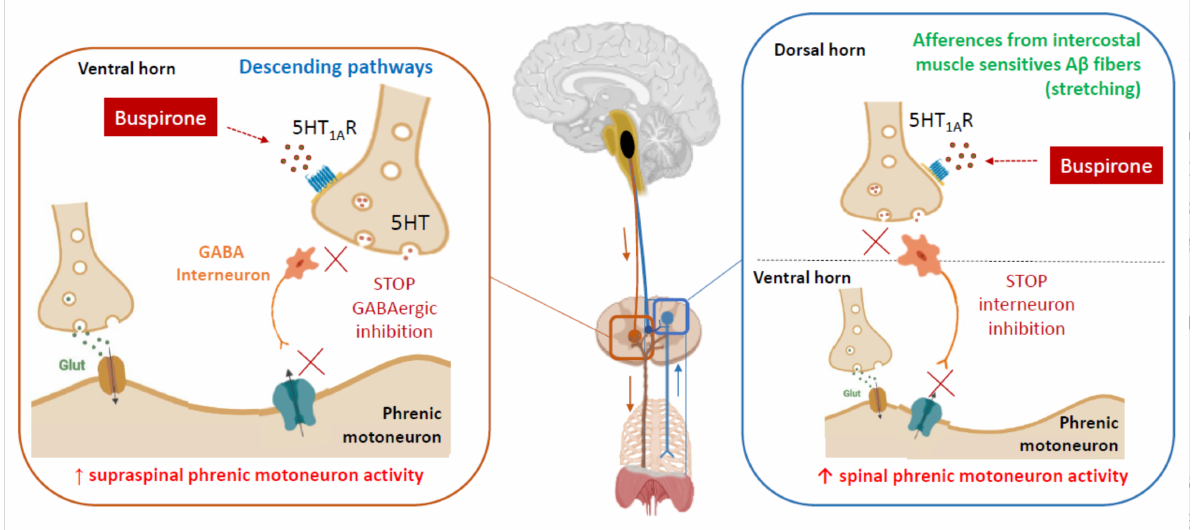
Figure 2. Expected mechanisms of action of Buspirone on respiratory network. Buspirone